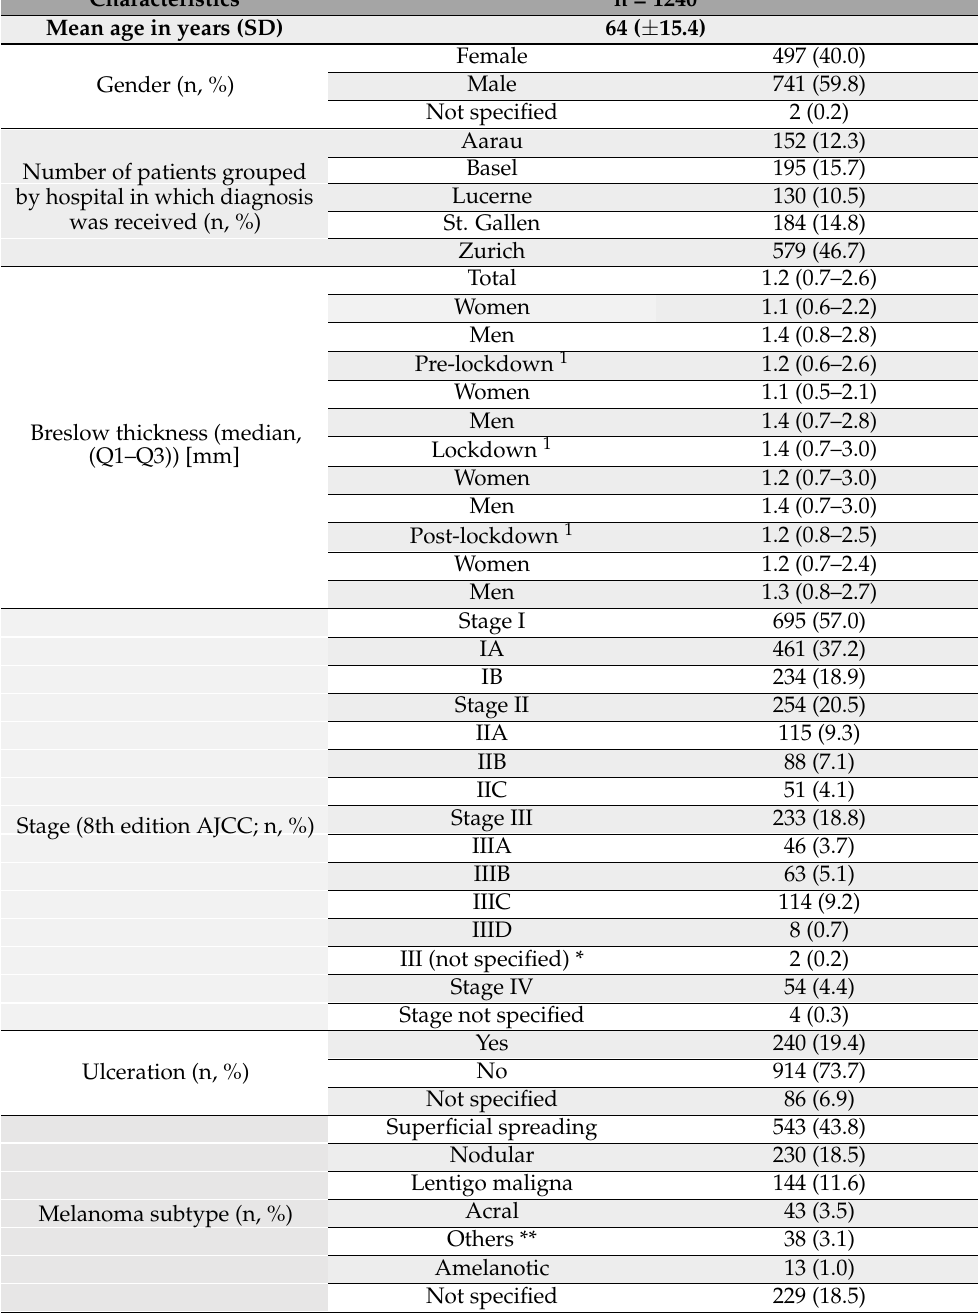
Table 1. Characteristics of patients with invasive primary cutaneous